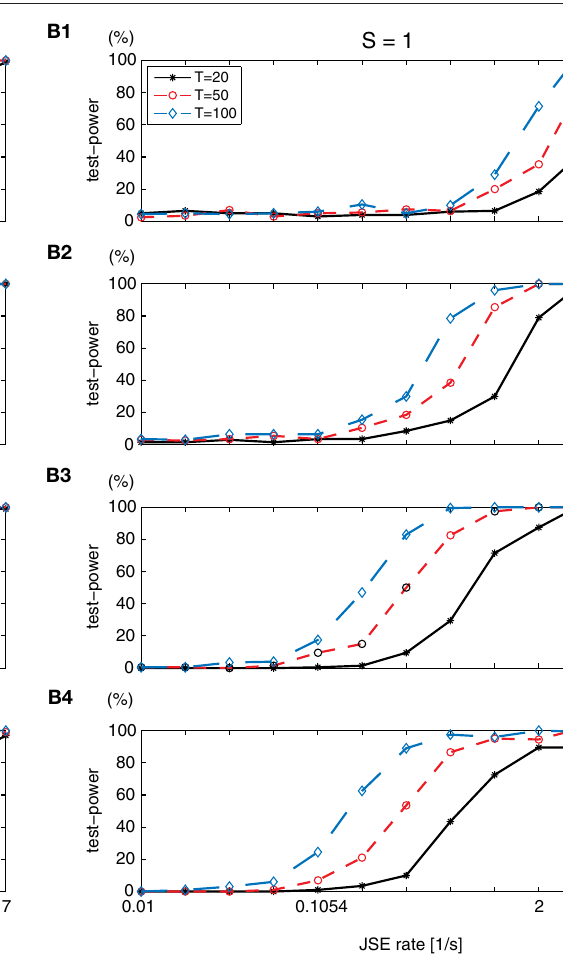
Figure 9 | Test power of multivariate NeuroXidence in relation to the number of trials ( T ) and the number of surrogates ( S ). One simulated data set was modeled as a single-interaction process based on a Poisson process, while the other five simulated data sets were generated by independent and homogenous Poisson processes. Rows 1–4 show the test-power dependencies